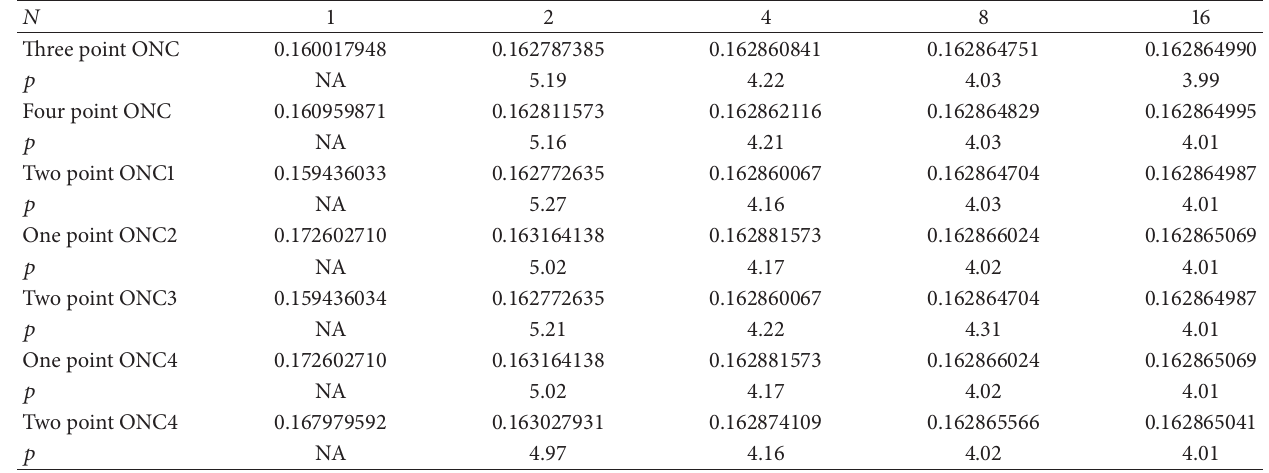
1 (𝑥 ln (1 + 𝑥)/(1 + 𝑥 2 ))𝑑𝑥 . 0